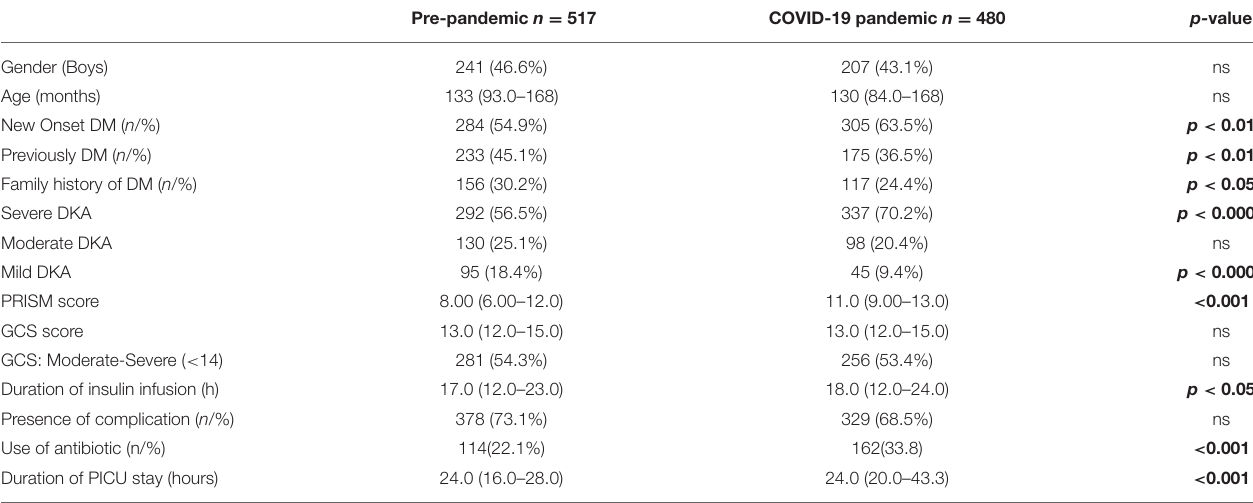
TABLE 1 | Clinical features of children with DKA during pre-pandemic and COVID-19 pandemic period. Pre-pandemic n = 517 COVID-19 pandemic n = 480